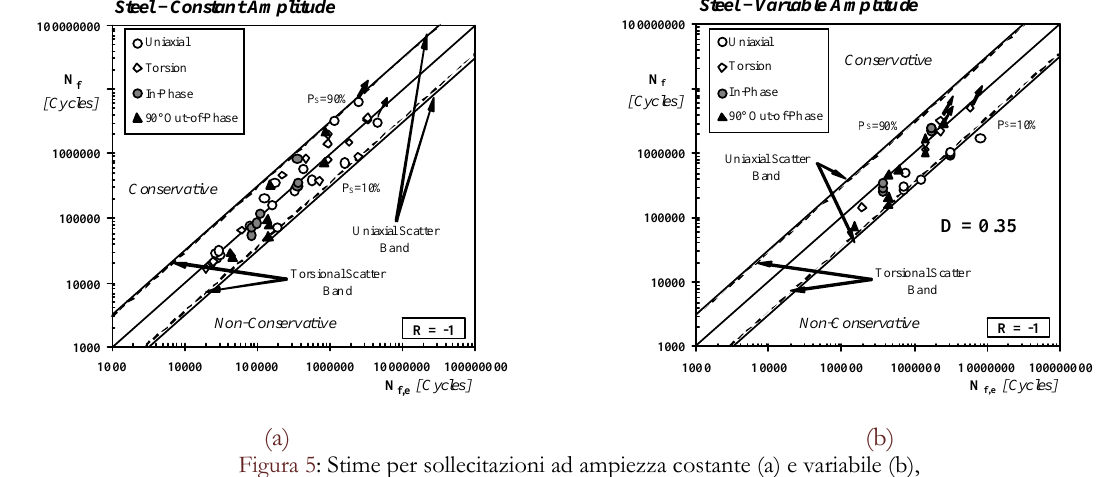
Figura 5: Stime per sollecitazioni ad ampiezza costante (a) e variabile (b),